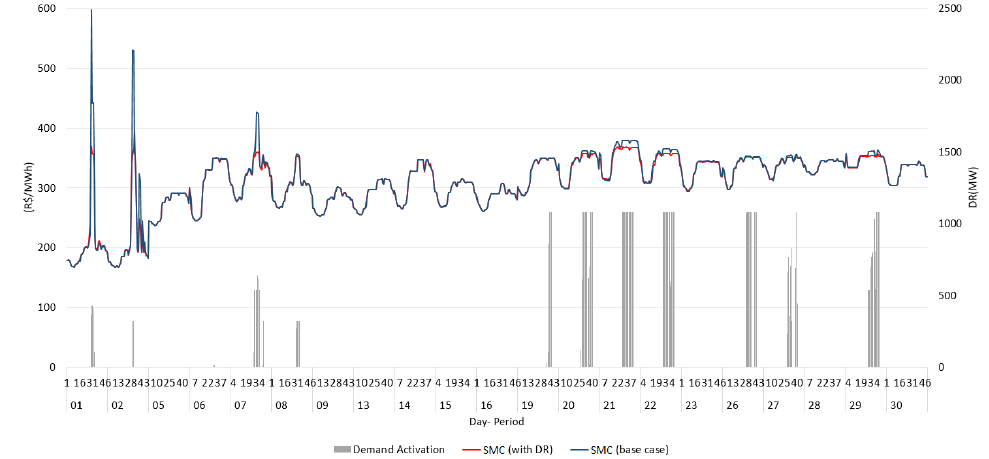
Figure 7. Southeast/Midwest SMC values.